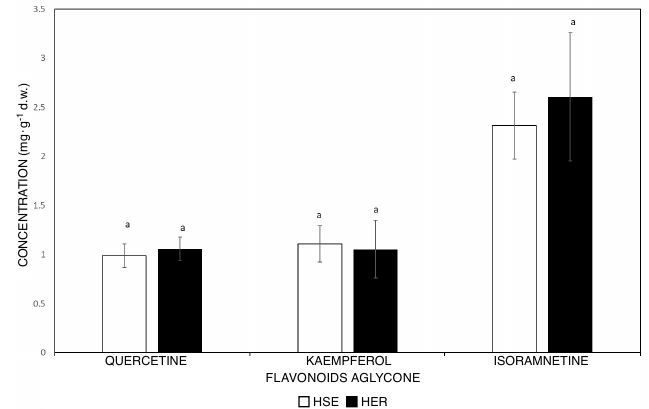
Fig. 5: Concentration of quercetin, kaempferol, and isorhamnetin in un- sweetened fl akes and fl akes sweetened with rebaudioside A (6 g L -1 ) of nopal O. fi cus-indica cv. Atlixco. Values represent the mean ± standard deviation of 3 replicates. Bars with different letters for the same fl avonoid aglycone indicate statistically signifi cant difference by Tukey’s test (p < 0.05). Abbreviations: dw = dry weight.